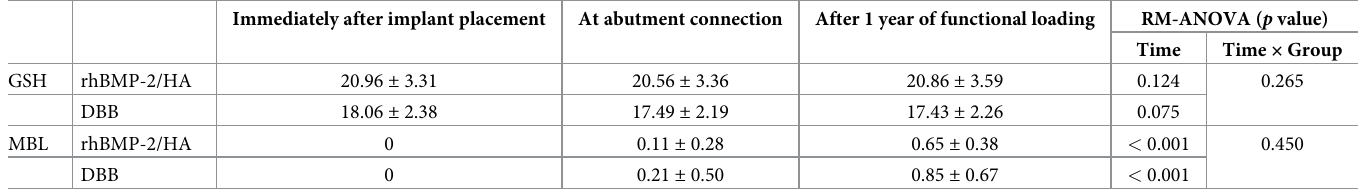
Table 2. Grafted bone height and marginal bone loss in the radiographic analysis. Immediately after implant